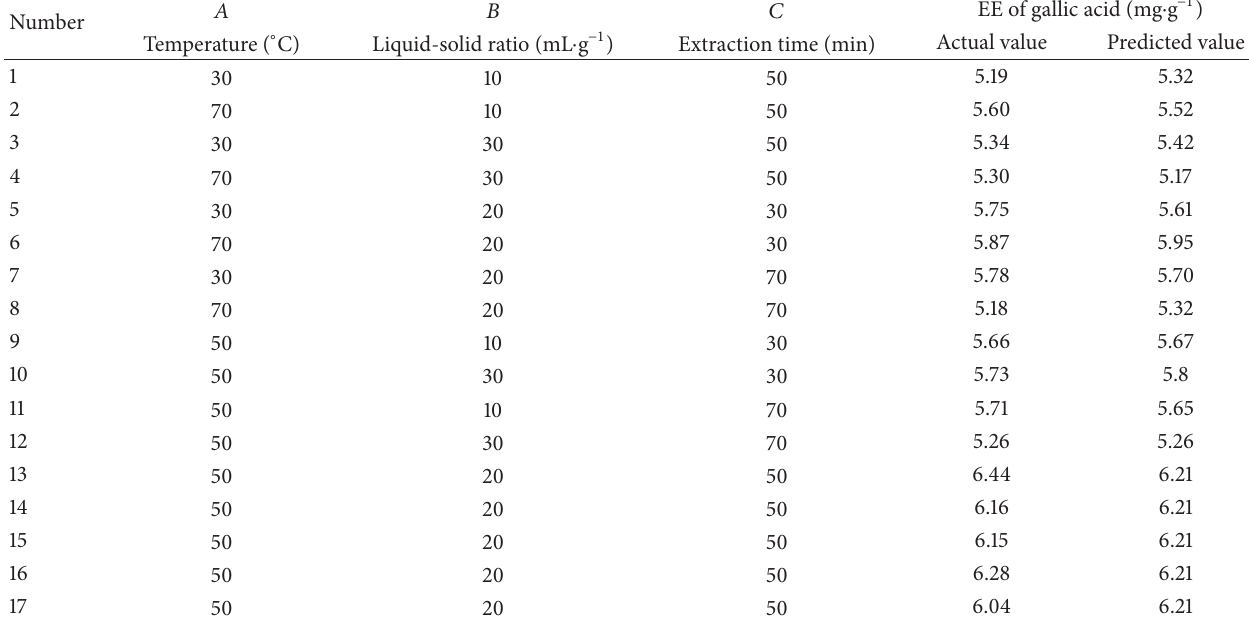
Table 1: Design and results by RSM for gallic acid extraction from Suaeda glauca Bge.